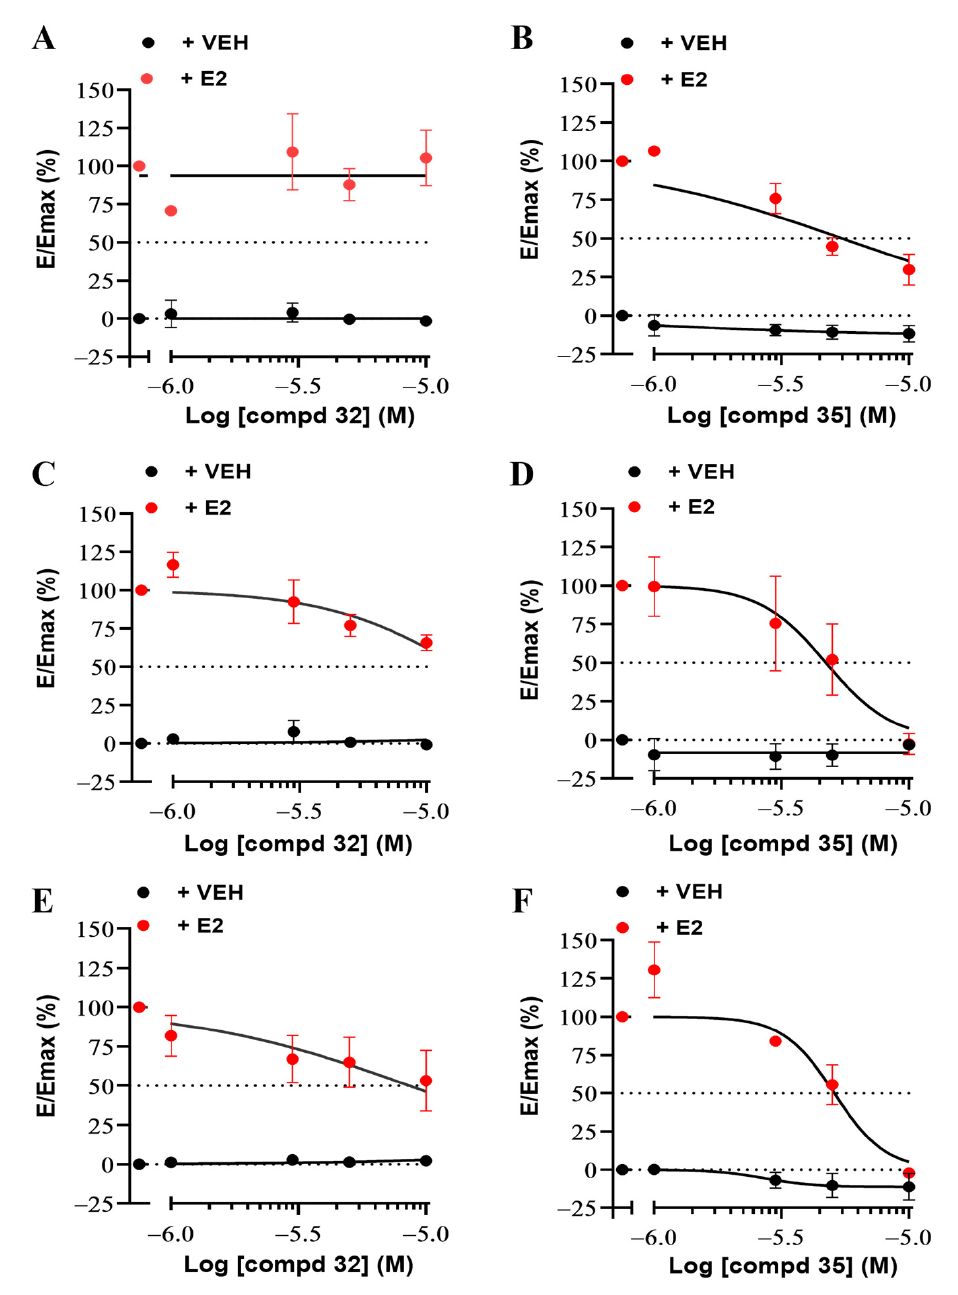
Figure 3. 5-hydroxy-2 H -pyrrol-2-ones 32 and 35 show a time-dependent antagonism on ER-dependent transcriptional activity. E2-depleted T47D-KBluc cells were pretreated with compounds 32 ( A , C , E ) or 35 ( B , D , F ) in a dose-response (1–10 µM) for ( A , B ) 3 h, ( C , D ) 12 h or ( E , F ) 24 h, before addition of vehicle (VEH; 0.05% DMSO, ● ) or E2 (0.1 nM, ● ) for 16–24 h. Relative Luciferase activity (RLU) was measured as described in the Material and Methods. The maximal luciferase activity or Emax (15.19 ± 1.71-fold induction) was induced by E2, and the efficacy (E) of each treatment, as compared with Emax, was calculated (E/Emax %). Dotted lines are shown at 0 % and 50 % of E/Emax. Non-linear regression analysis was applied with GraphPad Prism software 8.4.3 to